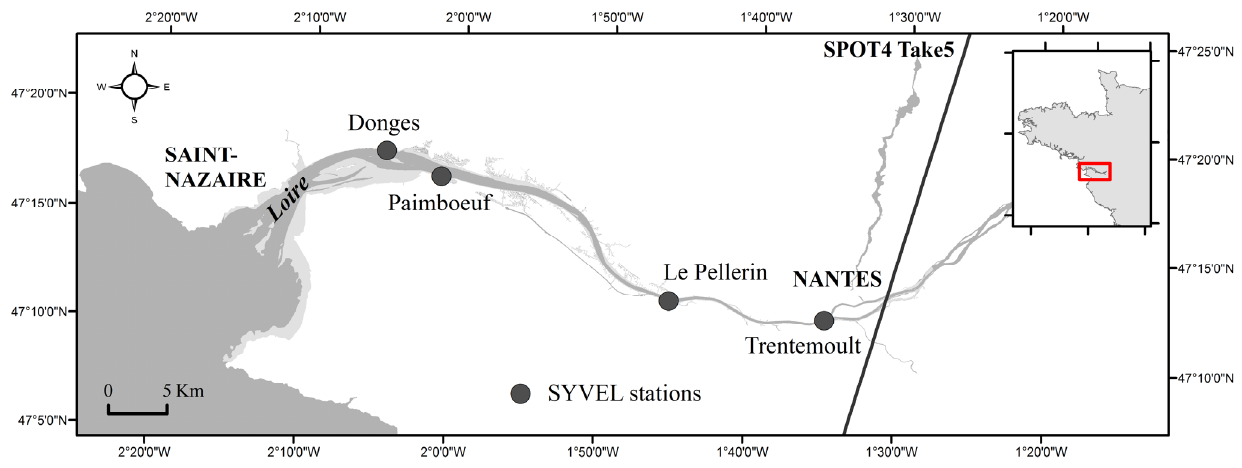
Figure 2. Map of the Loire estuary showing SPOT4 (Take5) spatial coverage and the location of the automated turbidity stations of the SYVEL network.